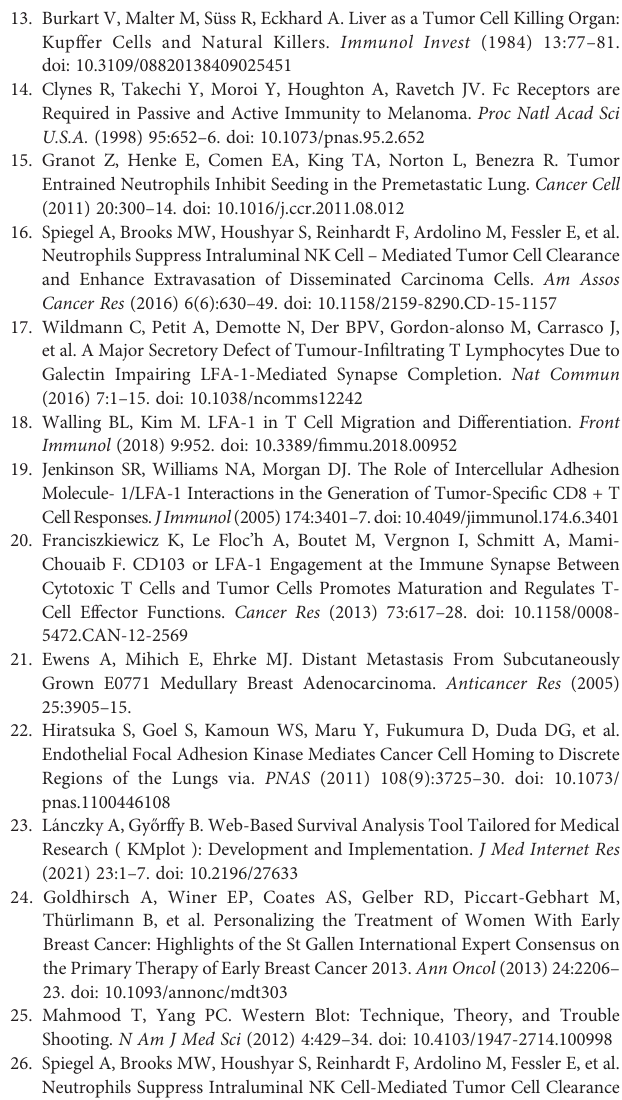
Supplementary Table 1 | Expression levels of selected genes in single 4T1 CTC (n=4),CTCclusters(n=4)andCTC-neutrophilclusters(n=6)derivedfromorthotopic breast cancer lesions generated in 8 – 10-week-old female NSG females upon the injection with 0.5 × 106 4T1-GFP cells into the mammary fat pad. Data was obtained from Gene Expression Omnibus (NCBI; accession number GSE109761) and expression levels were de fi ned as log2 of Transcripts Per Kilobase Million (TPM). P values were determined by Kruskal – Wallis